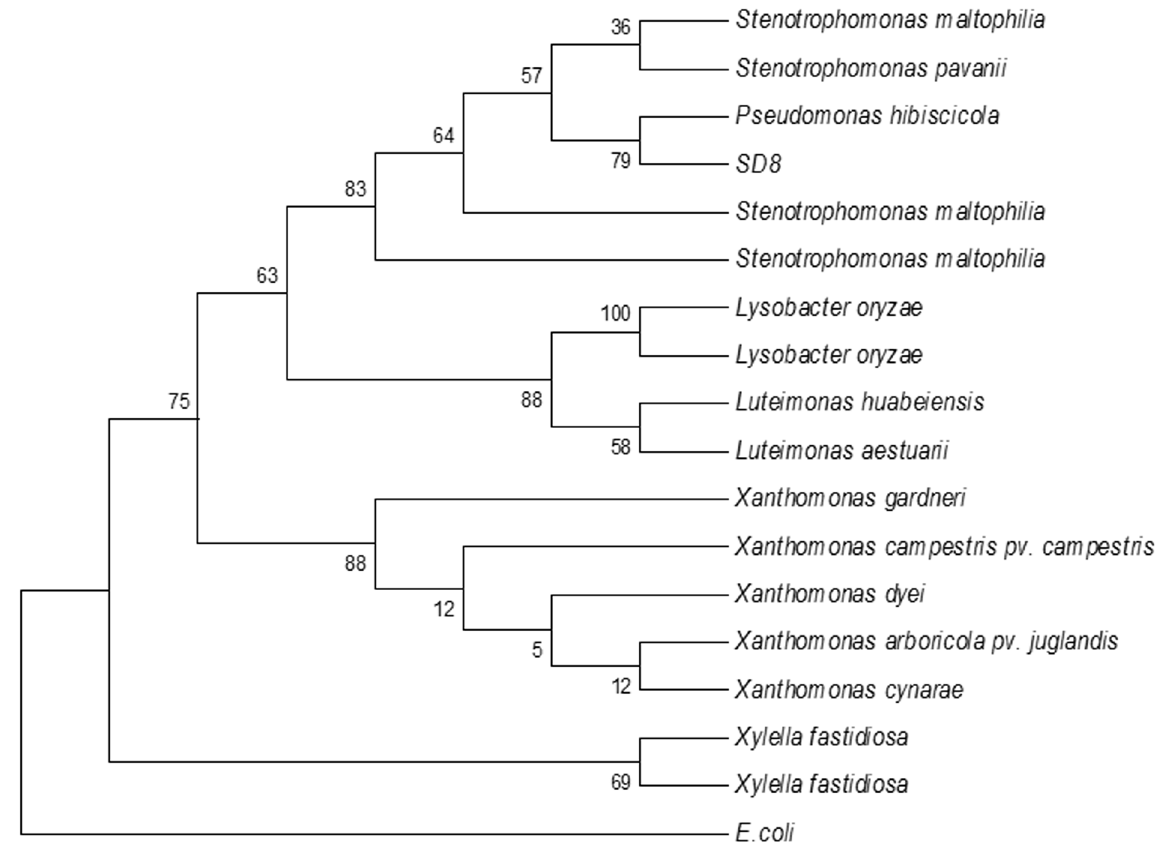
Fig 3. Phylogenetic tree analysis of strain SD8 based on comparison of its 16S rDNA sequence with those of closely related strains. The sequence of the 16S rDNA of E . coli was used as an outgroup. The tree was generated using the neighbor-joining v method.